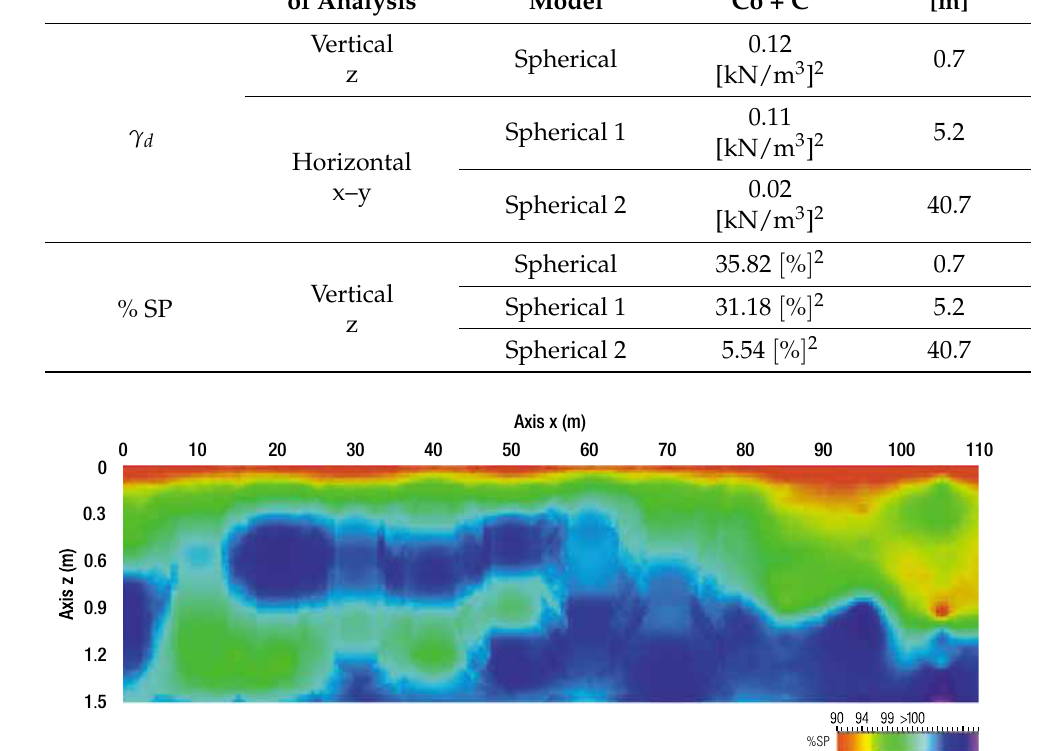
Figure 13. % SP compaction percentages estimated by OK. x-z plane longitudinal profile. Survey grid: second third, near the foot of the